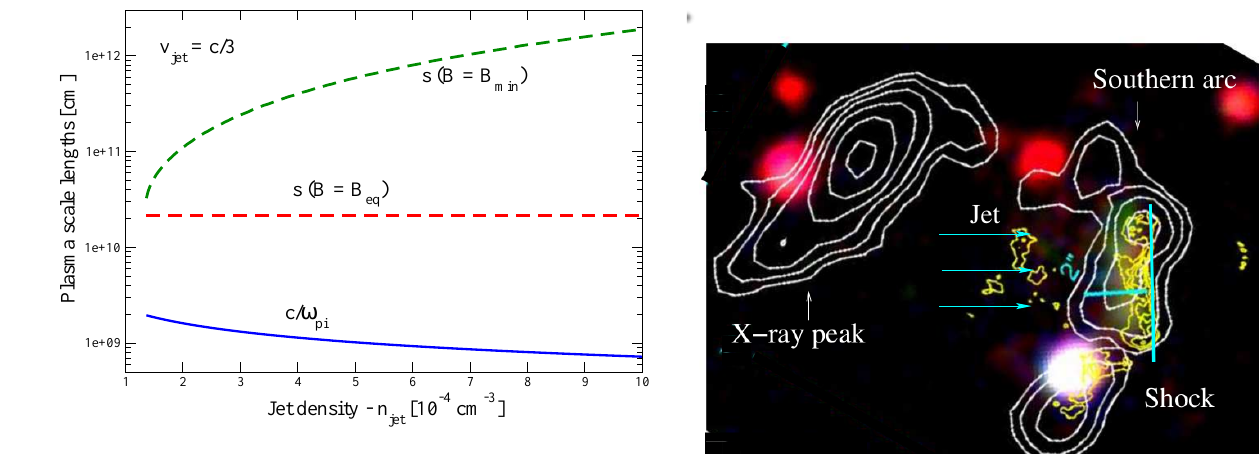
Figure 5. Magnetic turbulence scale length s ⊥ (dashed lines) and ion-skin-depth c /ω pi in the primary hotspot in Cygnus A. (See [28] for the same plot with di ff erent values of v jet .)